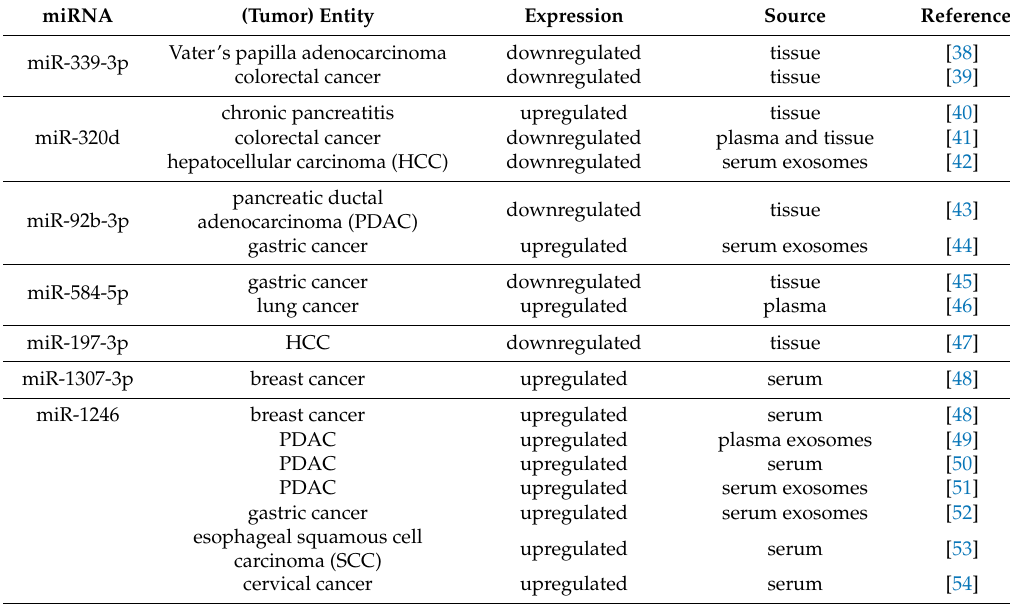
Figure 1. Detection of tumor-specific miRNAs in the plasma. ( A ). Principal component analysis of miRNA expression in plasma derived from non-tumor and tumor-bearing (MIA PaCa-2) mice. Analysis of all miRNAs in the dataset separates plasma samples derived from control mice (no tumor) to tumor-bearing (MIA PaCa-2) mice (PC1) and PC2 shows intra-group variability. ( B ). The upregulated miRNAs in the plasma of tumor-bearing (MIA PaCa-2) mice compared to the plasma of non-tumor-bearing mice are shown. Significant miRNAs were selected based on a log2 fold change ≥ | 1 | and an adjusted p -value of ≤ 0.05. Only transcripts with a base mean ≥ 50 were included. Hereinafter, the miRNAs upregulated in plasma samples of tumor-bearing mice are discussed in the context of the recent literature and summarized in Table 1. Table 1. Overview of miRNAs found to be deregulated in our analysis of plasma samples of tumor-bearing mice and associated